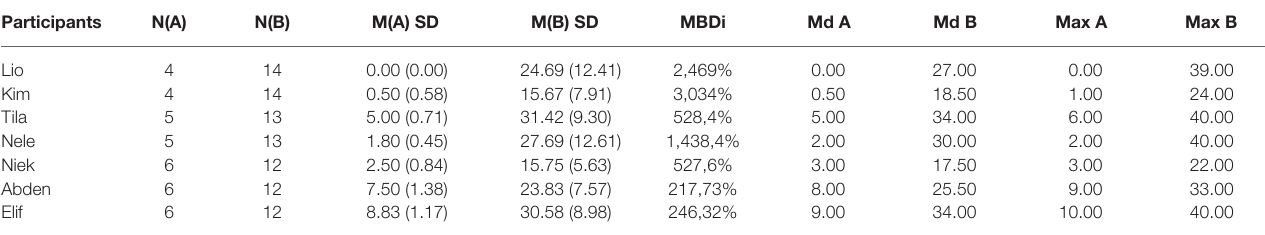
TABLE 2 | Descriptive data for expressive vocabulary. Participants